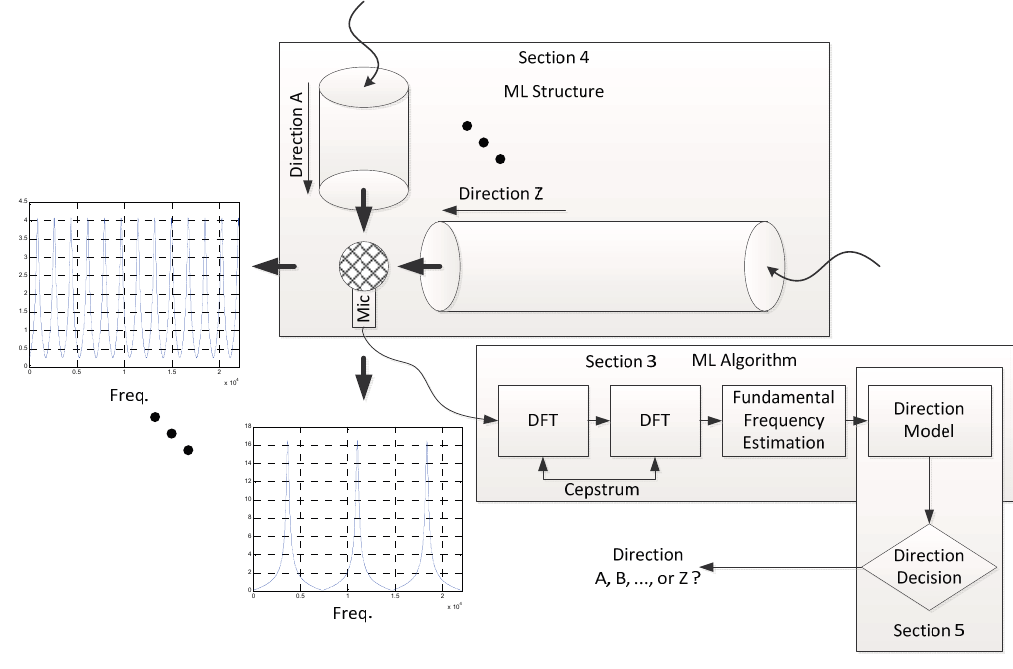
Figure 2. System architecture of proposed ML system with paper